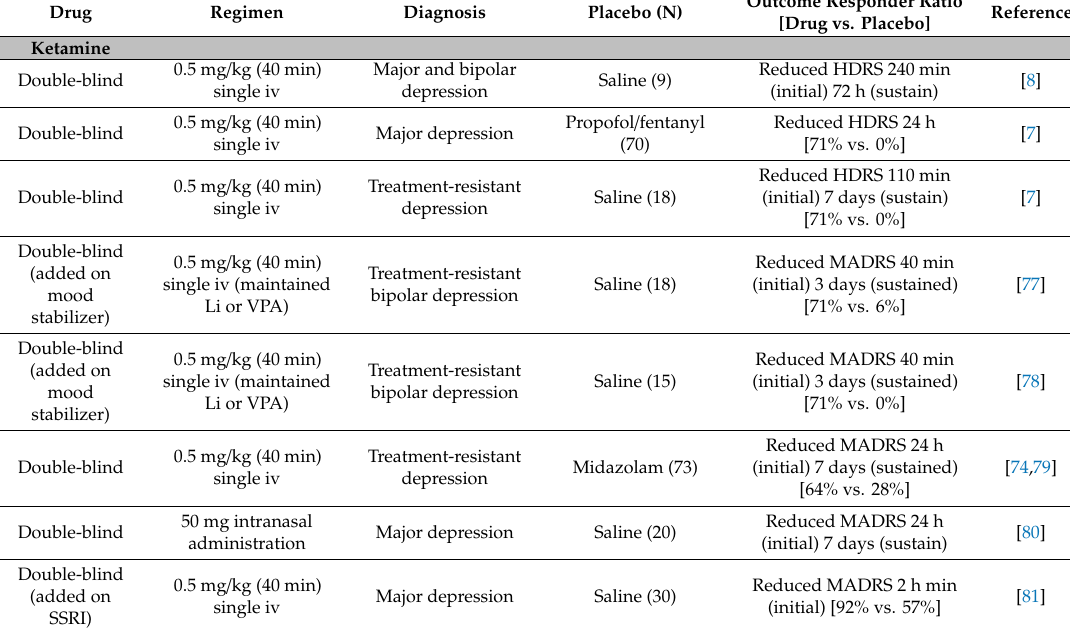
Table 1. Completed double-blind, placebo-controlled trials assessing ketamine and other